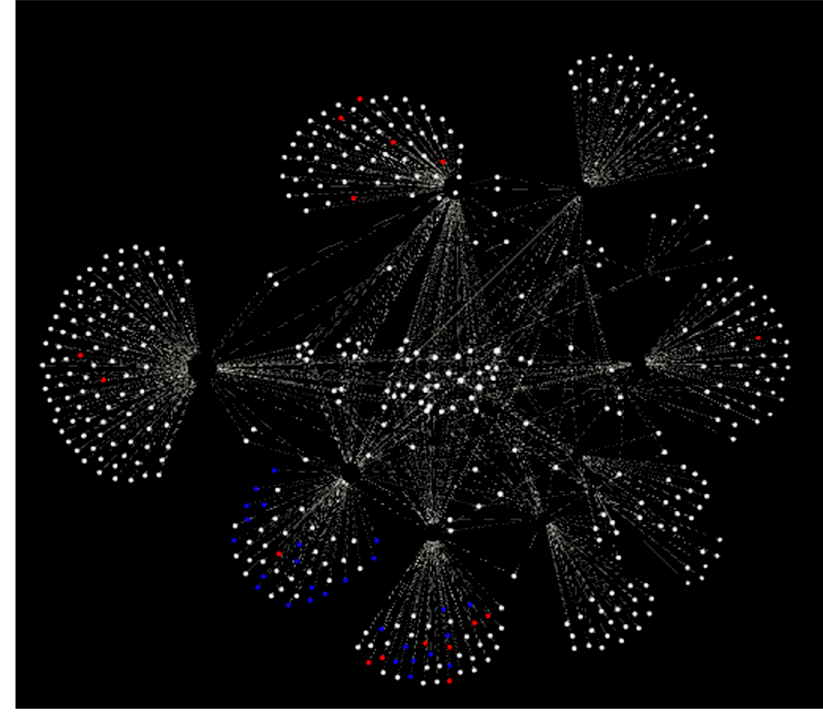
Figure 2. Disciples (red) and local gods